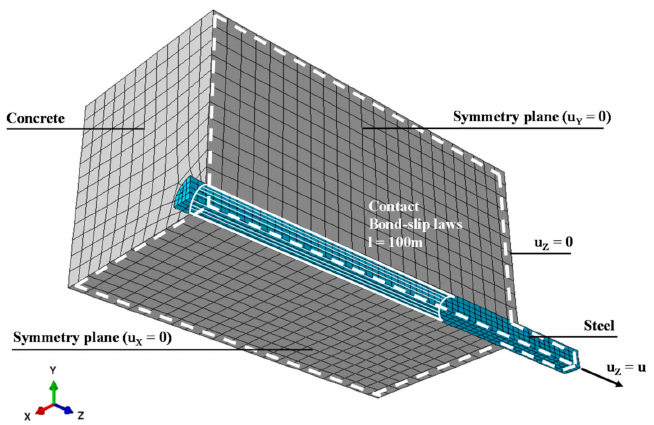
Figure 4. Geometry and mesh of the FE model